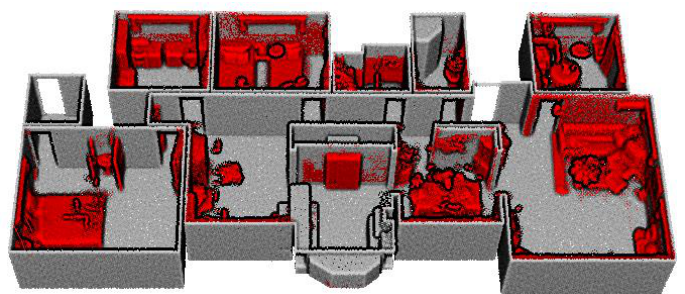
Figure 4. Structural points (grey) and the object points (red) that are segmented from the registered point cloud of our dataset A1.